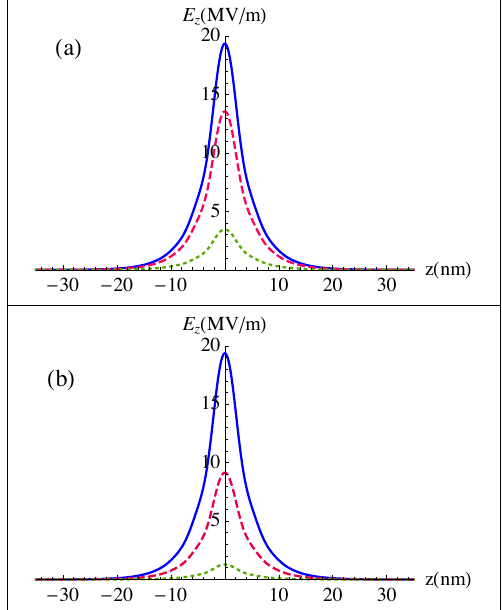
Figure 3. Confined plasmonic fields near the GNDs layer with a thickness of t = 0.34 nm, Fermi energy of E F = 1 eV, mobility of 20,000 cm 2 /V s and δ GNDs = 100 excited by a 10 fs-sech pulse of wavelength λ 0 = 30 µ m, in the presence of the metallic contact, i.e., an Ag NPs lattice of δ AgNPs = 150 and ( a ) width of: W = 0.25 λ 0 (solid), W = 0.5 λ 0 (dashed) and W = 1.2 λ 0 (dotted) at x / W = 0.45. The two lattices are embedded in a dielectric of (cid:101) = 3. ( b ) width of W = 0.25 λ 0 for the metallic contact at x / W = 0.45. The two lattices are embedded in dielectric medium of (cid:101) = 3 (solid), (cid:101) = 6 (dashed), (cid:101) = 10